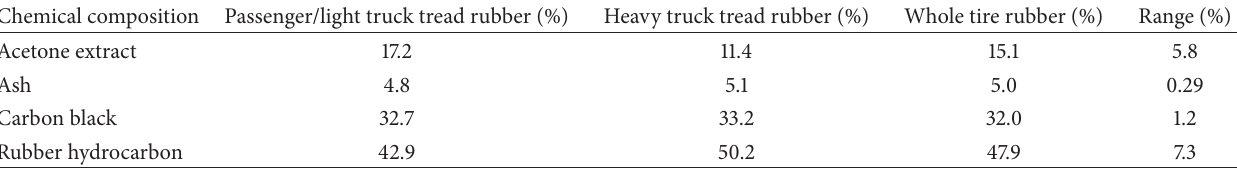
Table 4: Chemical composition of various types of tires (adopted from